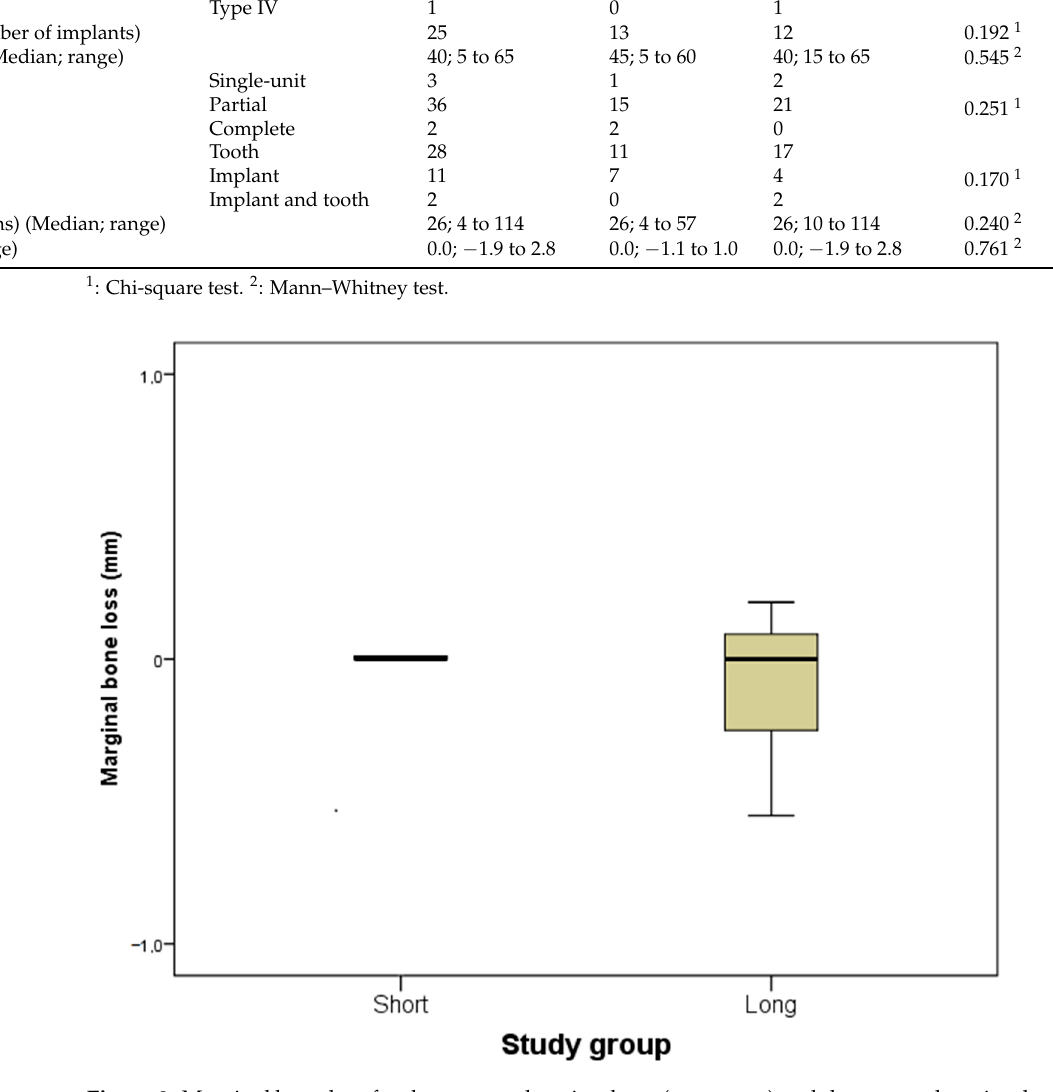
Figure 2. Marginal bone loss for the narrow short implants (test group) and the narrow long im- plants (control group). (control